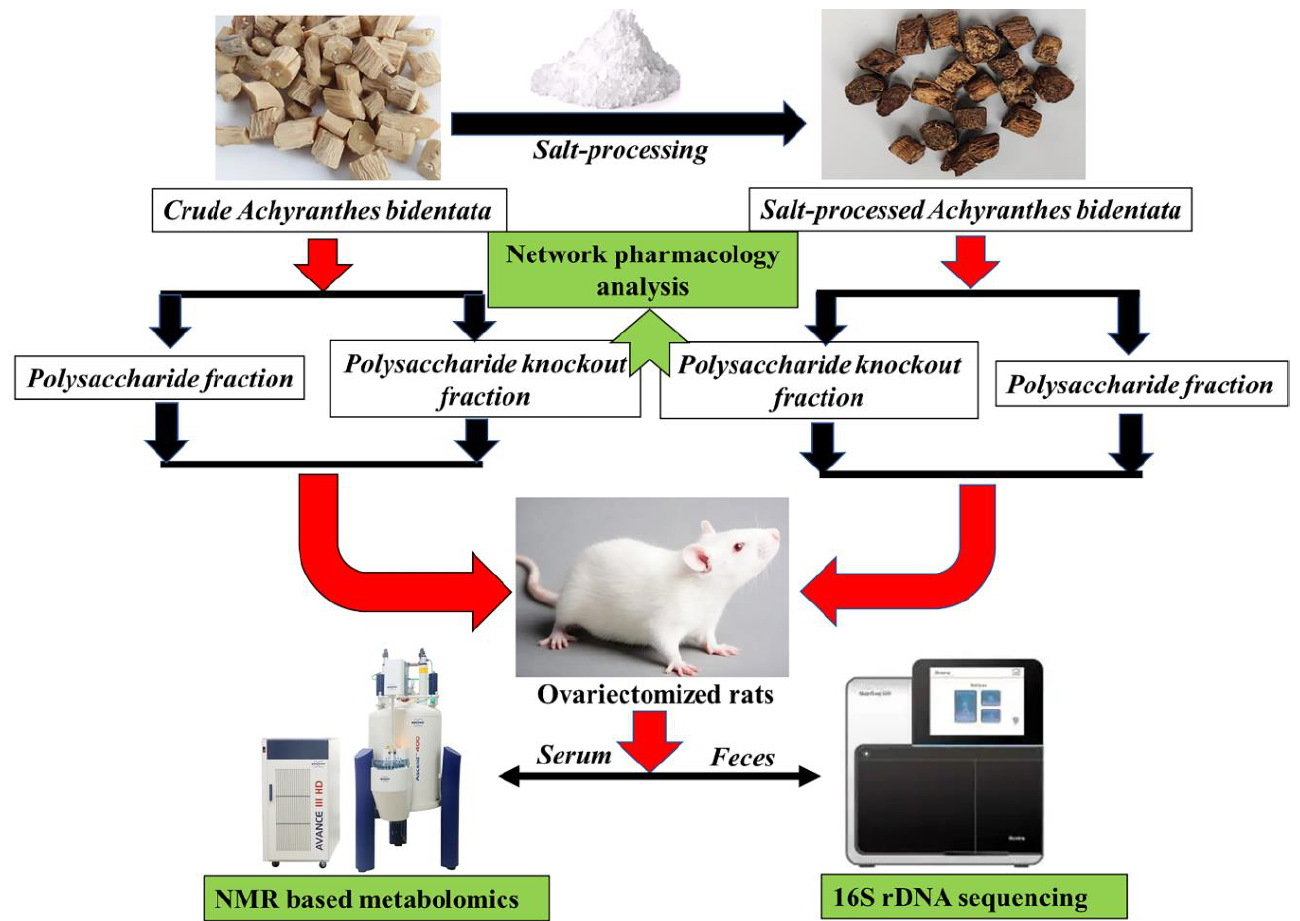
Figure 1. The schematic flowchart of the combinatory strategy for dissecting the anti-osteoporosis mechanism of four components from crude and salt-processed AB.